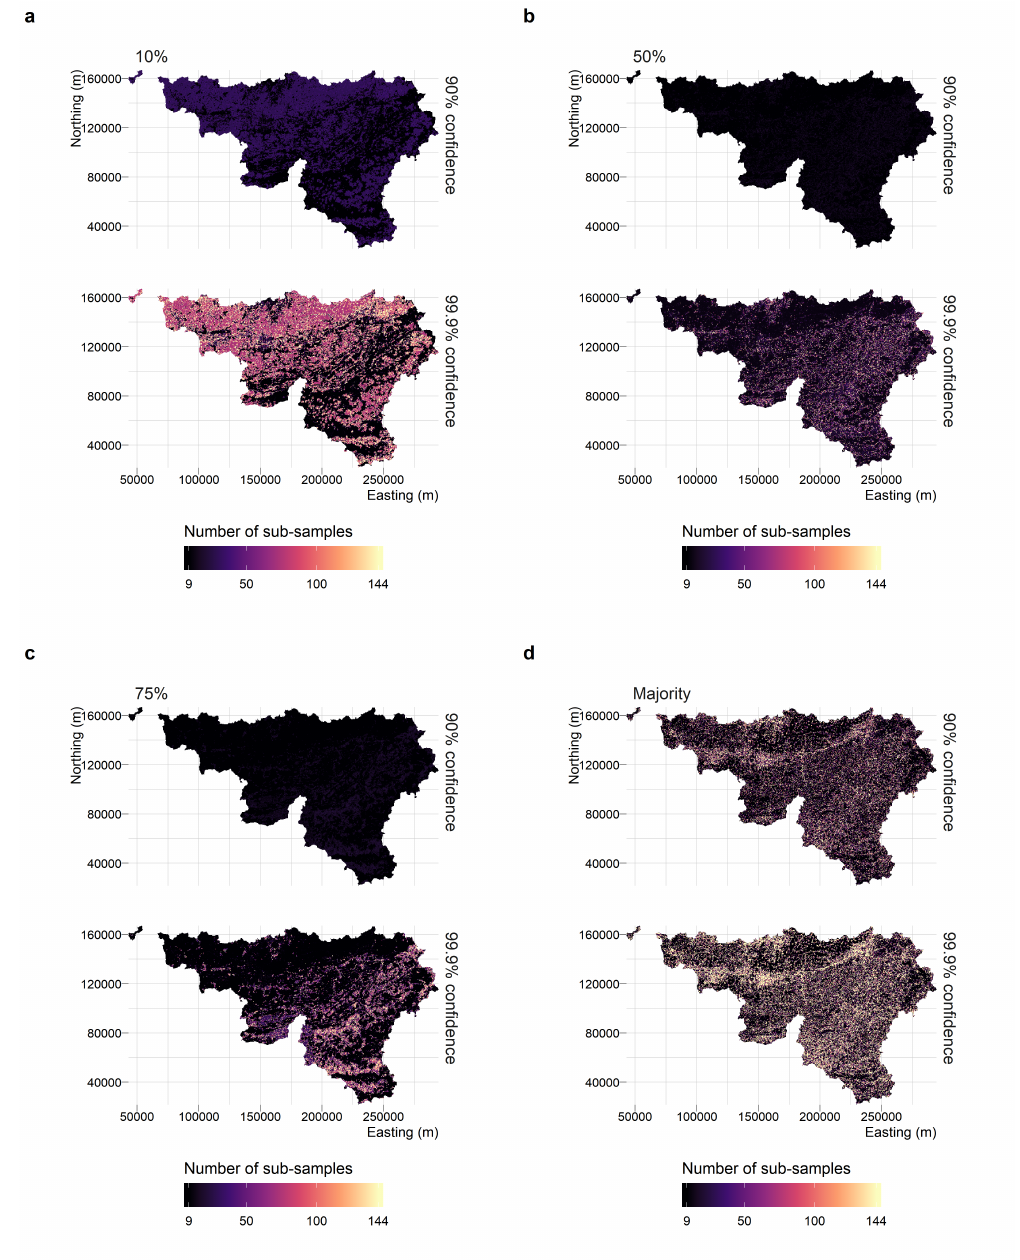
Figure 7. Optimized number of sub-samples for binary classification systems at 10% ( a ); 50% ( b ); 75% ( c ); and for a majority classification system ( d